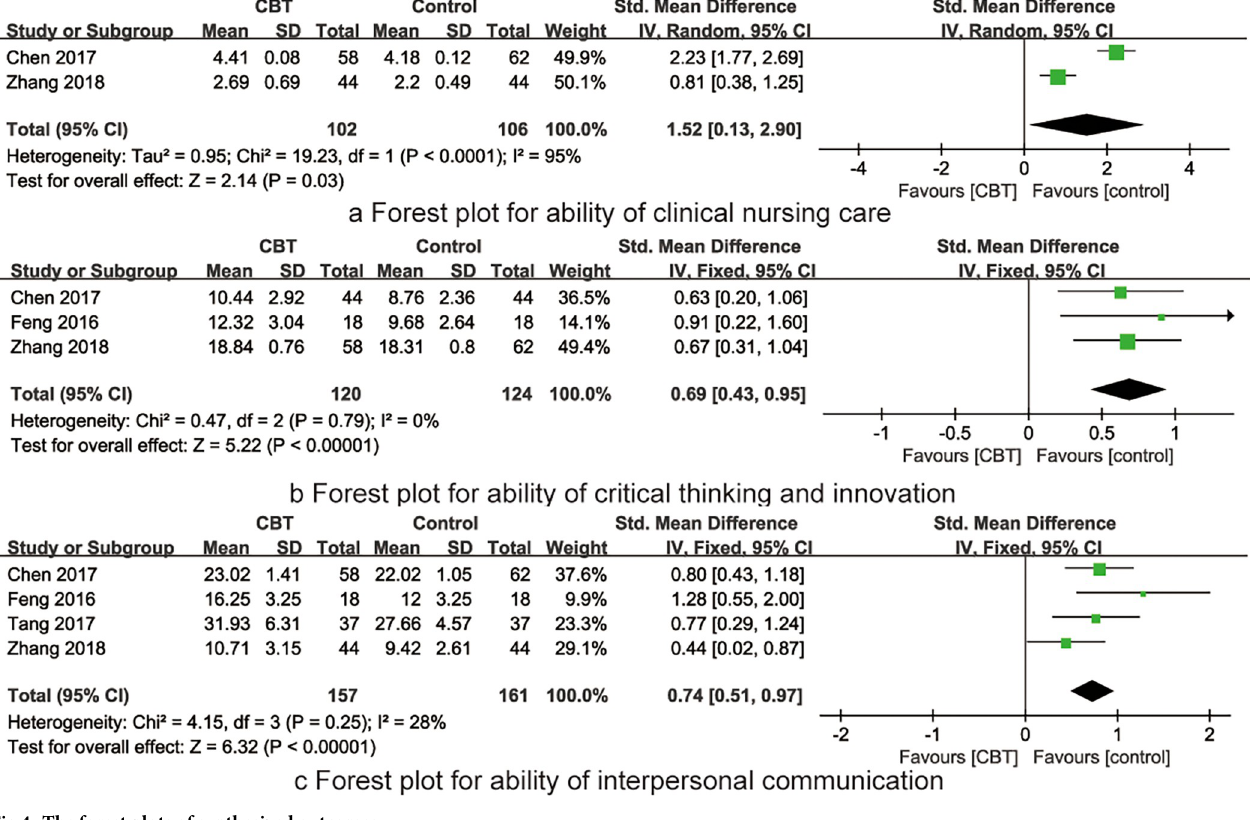
Fig 4. The forest plots of synthesized